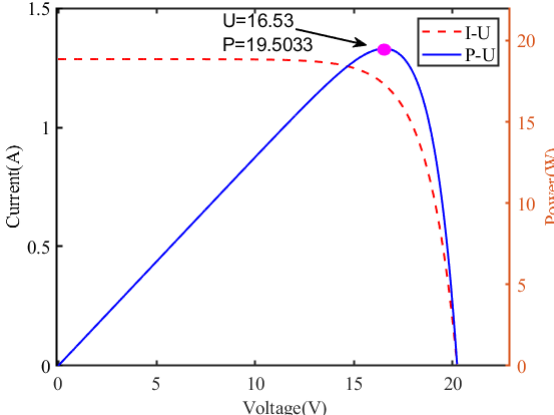
Figure 3. Photovoltaic cell output characteristics curve.